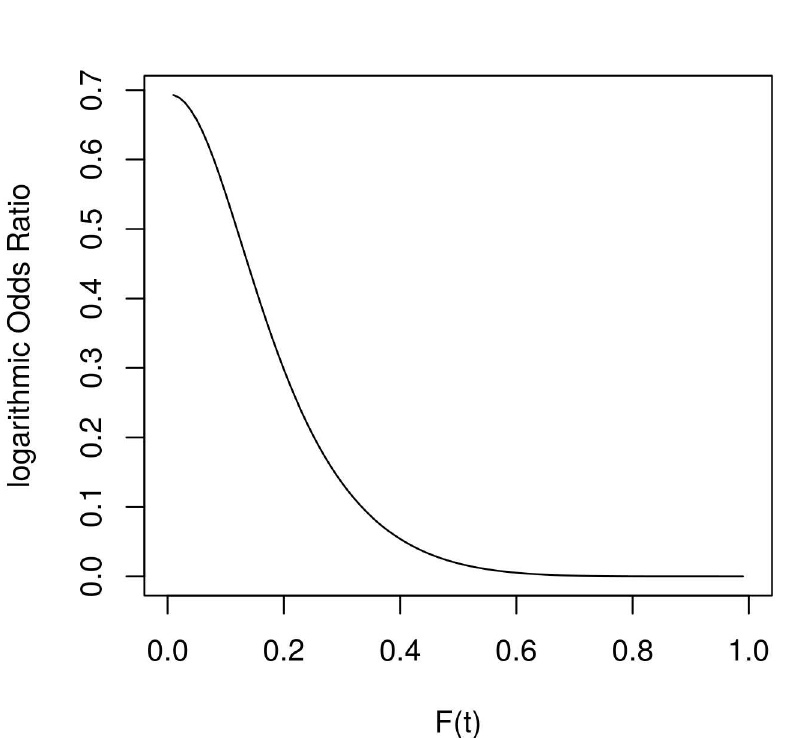
Fig 5. Diagram comparing 1 and 12 processors. For 6